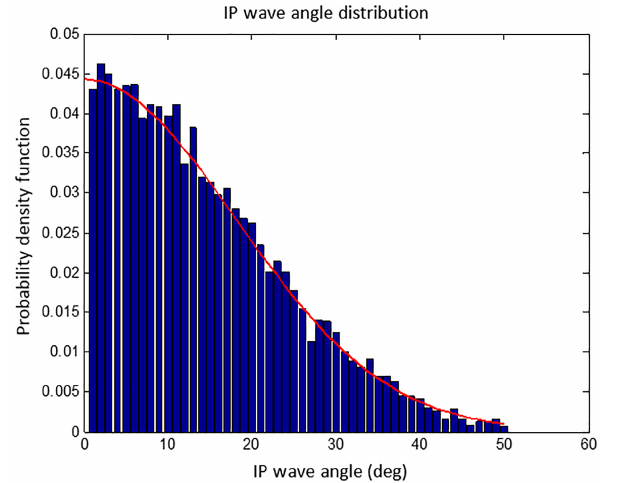
Figure 14. Half-Gaussian distribution of sample set for IP fiber misalignment magnitudes used in Case